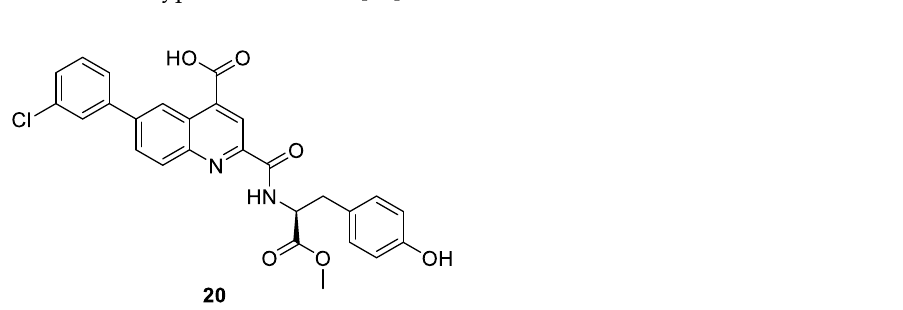
Figure 4. Chemical structure of quinoline-based type 1.5 inhibitor of monomeric CDK2.